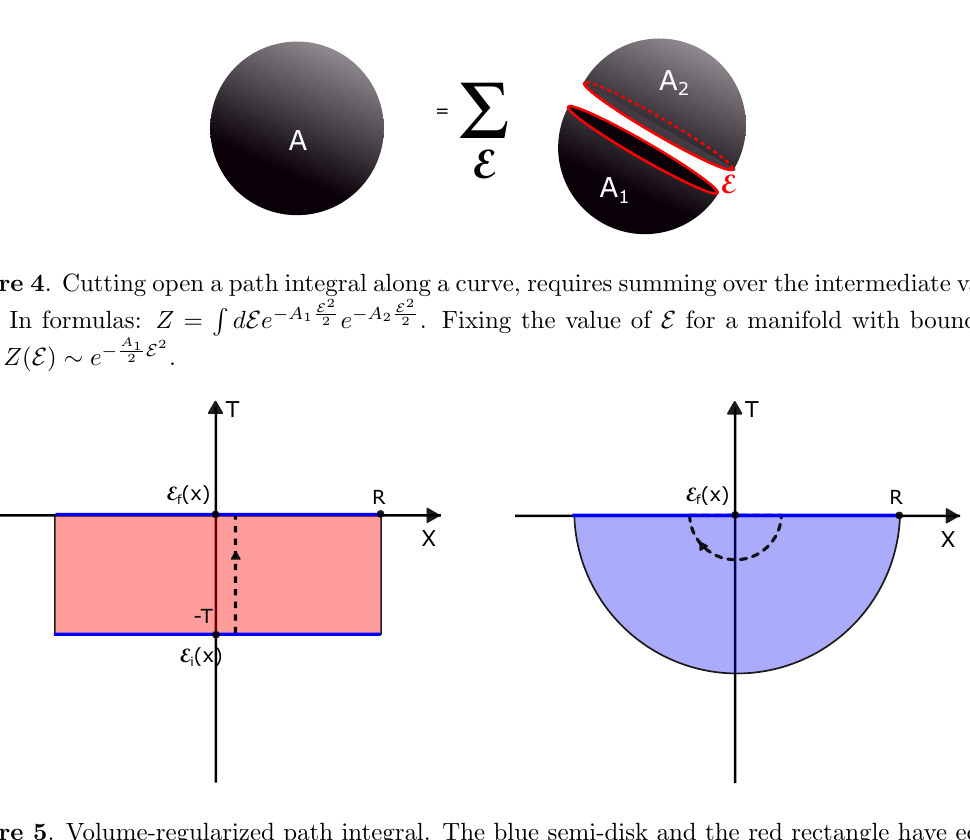
Figure 5 . Volume-regularized path integral. The blue semi-disk and the red rectangle have equal area, and hence the (cid:12)nal state can be constructed using both